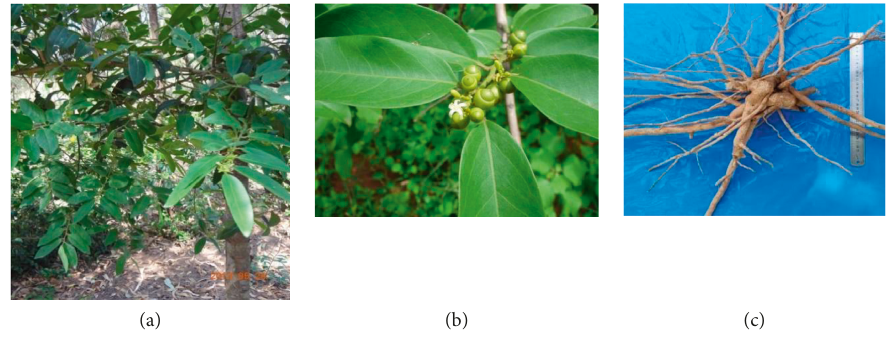
Figure 1: (a) Duong-dau tree, Olax imbricata ; (b) Duong-dau flower and fruit; (c) Duong-dau